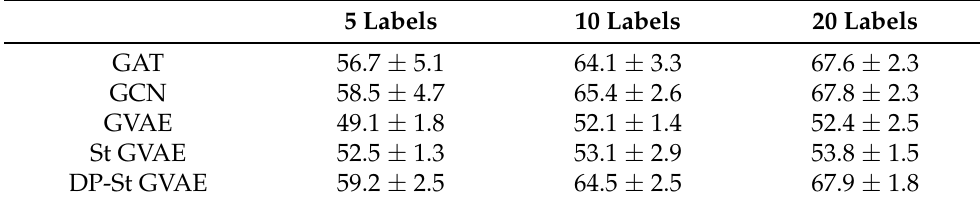
Table 6. Semi-supervised node classification prediction accuracy for Citeseer.